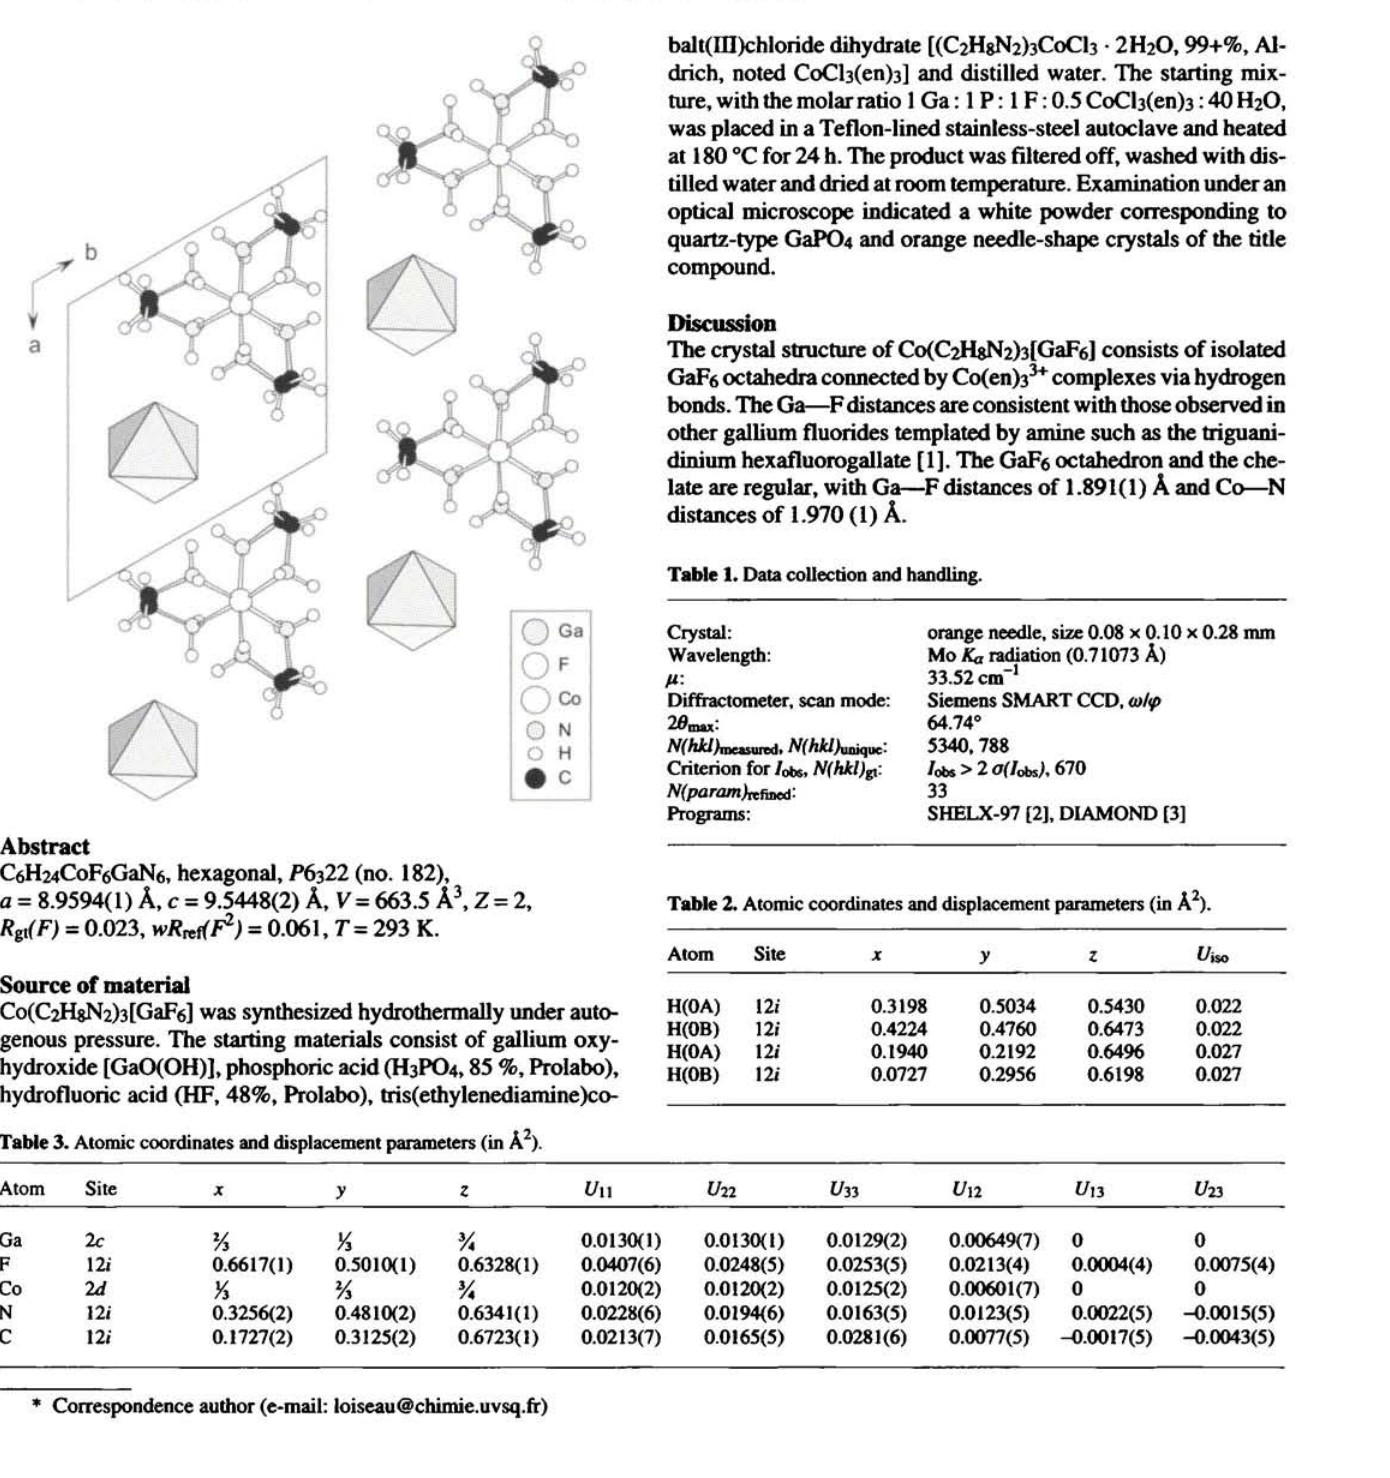
Table 3. Atomic coordinates and displacement parameters (in A 2